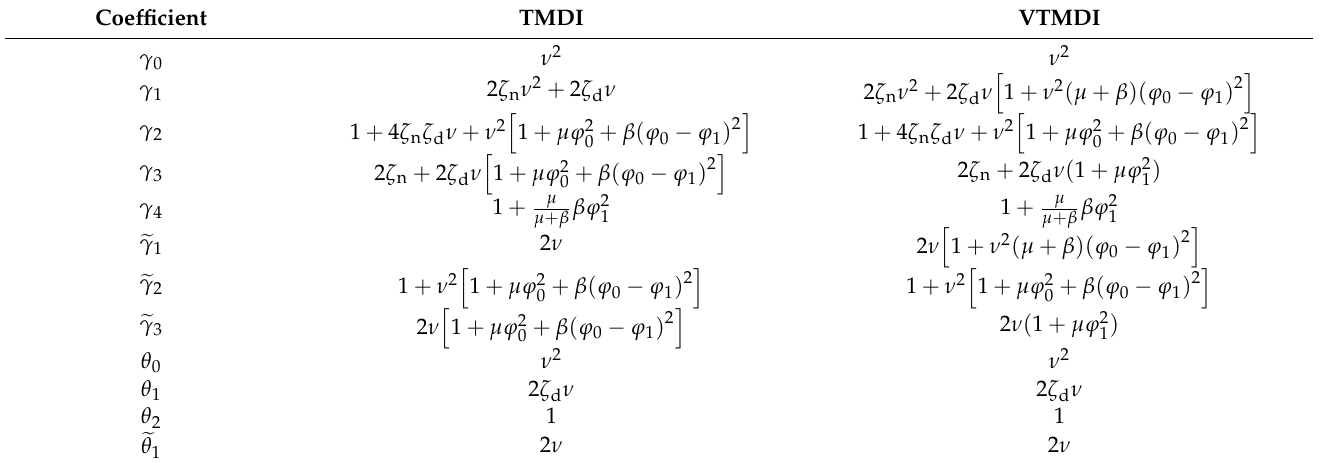
Table 2. Dimensionless coefficients of the normalized transfer function H ( s ) for TMDI and VTMDI. Coefficient